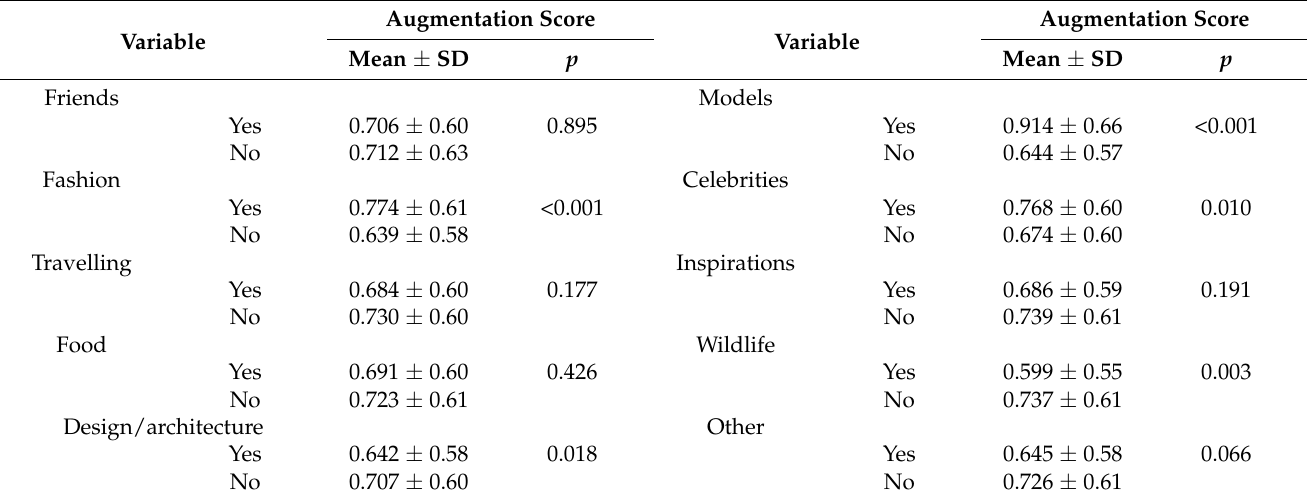
Table 6. Multinomial logistic regression analysis of association between searched Instagram content categories and augmentation score. Variable p OR